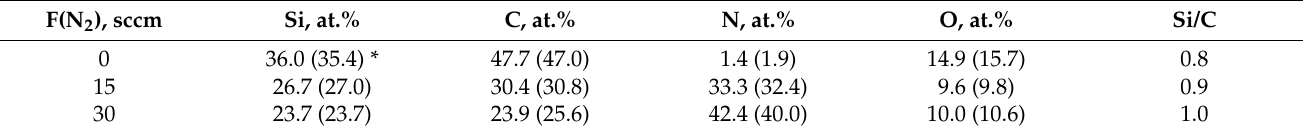
Table 4. Elemental composition of SiC x N y films obtained at a substrate temperature of 300 ◦ C. F(N 2 ), sccm Si, at.% C,